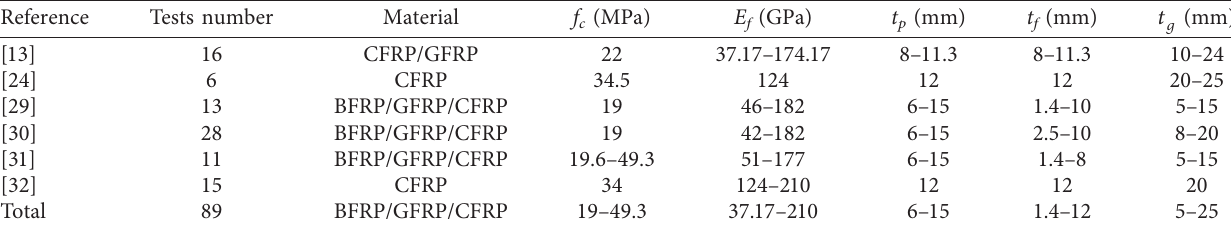
Table 2: Database under the adhesive-concrete interface failure mode.